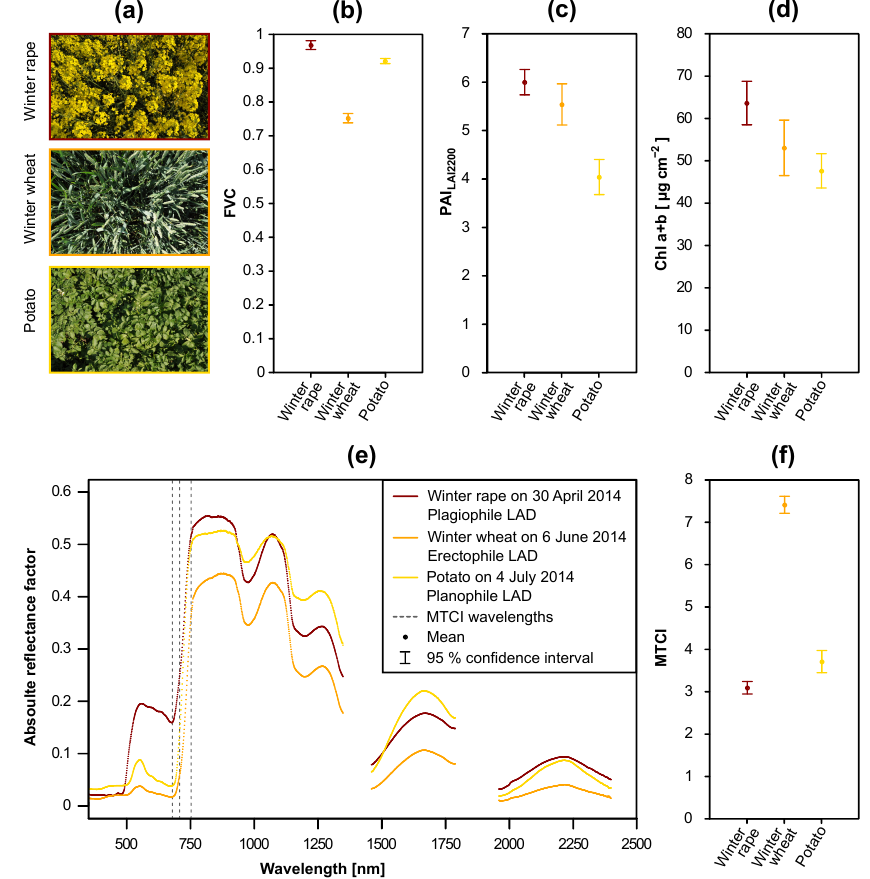
Figure 5. Differences in parameter characteristics, illustrated for fractional vegetation cover (FVC), plant area index (PAI LAI2200 ), leaf chlorophyll a and b content ( Chl a+b ), averaged absolute canopy reflectance factors, and the MERIS Terrestrial Chlorophyll Index (MTCI) following Dash and Curran (2004) for crops with varying leaf angle distributions (LADs) in similar phenological stages ( BBCHkeys : winter rape: 65–67; winter wheat: 69; potato: 69–70). Average values and the corresponding 95% confidence intervals were determined from measurements that were carried out on an elementary sampling unit (ESU), respectively. Uncertainties of mean spectra (95% confidence intervals; not shown to maintain clarity of the figure) are < 0.04 for winter rape and winter wheat and < 0.11 for potato. Wavelengths that are involved in the calculation of the MTCI are indicated with vertical dashed lines in Fig.